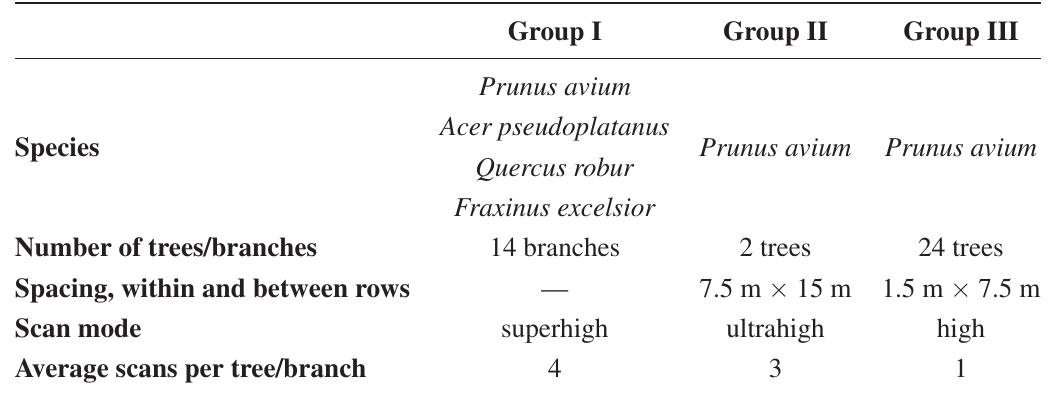
Table 2. Overview of the applied sample and scan parameters used for data